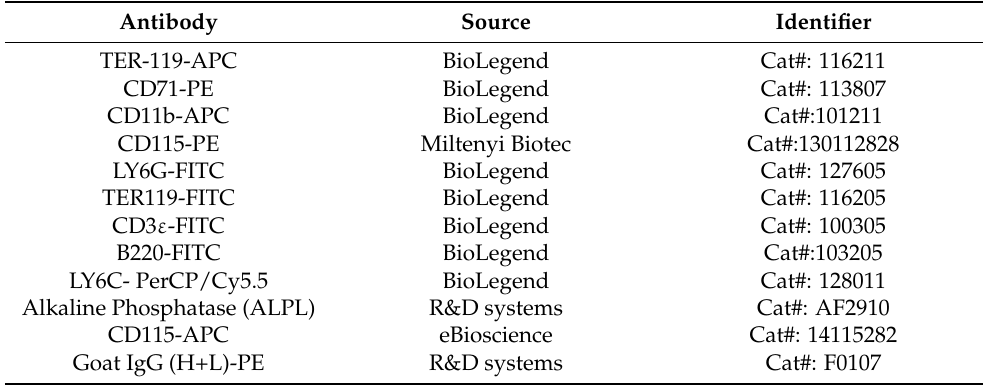
Table 1. Antibodies used for flow cytometry